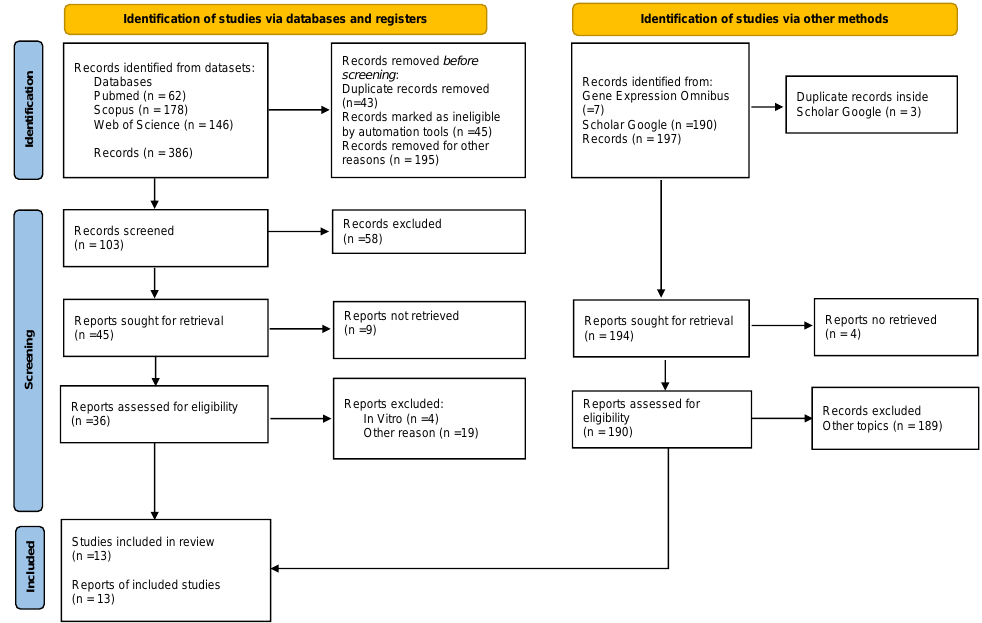
Figure 1. PRISMA 2020 Flow diagram depicting the selection of the eligible studies.